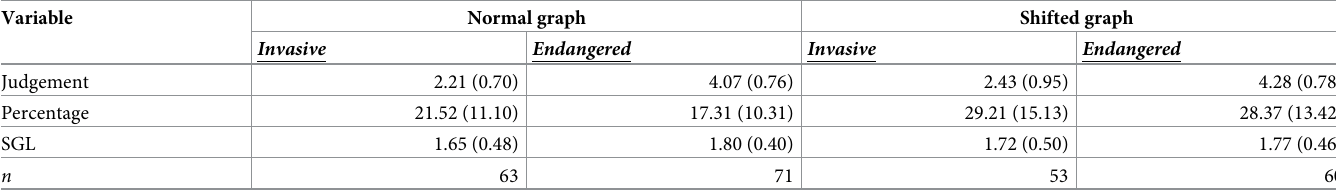
Table 2. Descriptive statistics of the other